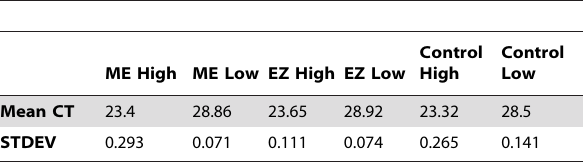
Table 3. Inhibition studies to test the co-purification of PCR